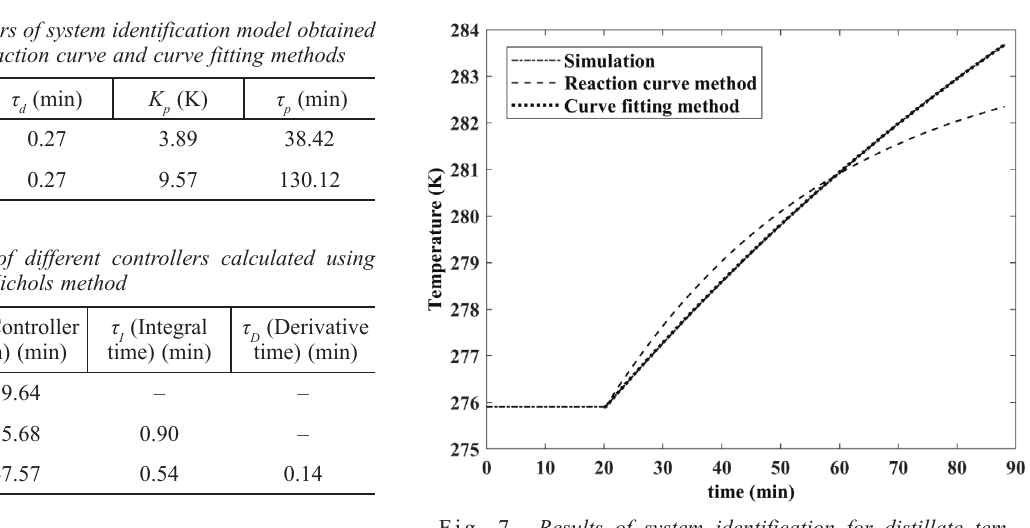
Fig. 7 – Results of system identification for distillate tem- perature